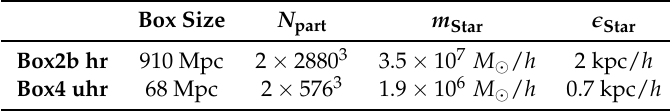
Table 1. Magneticum simulations used in this